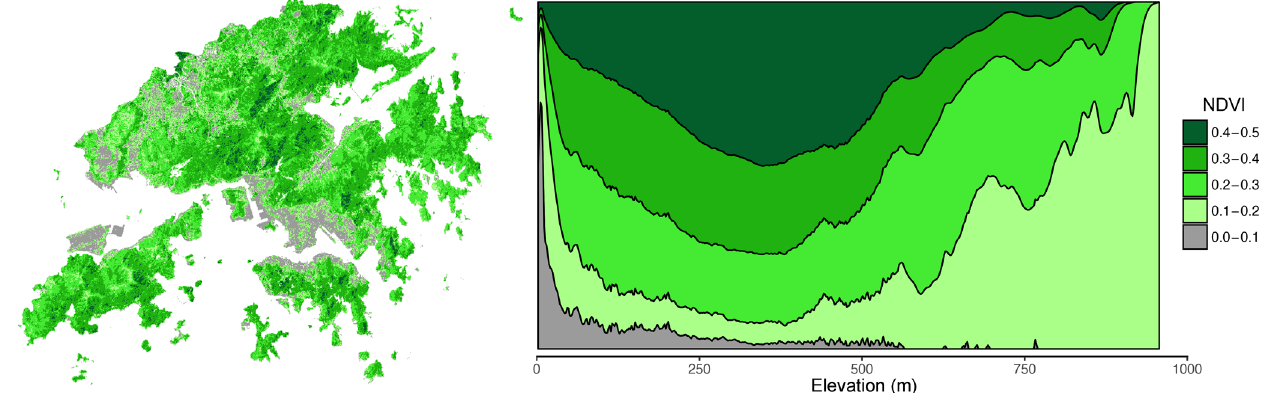
Figure 8. NDVI class composition over Hong Kong’s elevational range. The majority of land area near sea level is below NDVI 0.1, while Hong Kong’s highest-elevation areas are between 0.1 and 0.2, indicating short vegetation. The elevation range with proportionally the most dense vegetation (0.4 to 0.5 NDVI) is 300 to 400m.